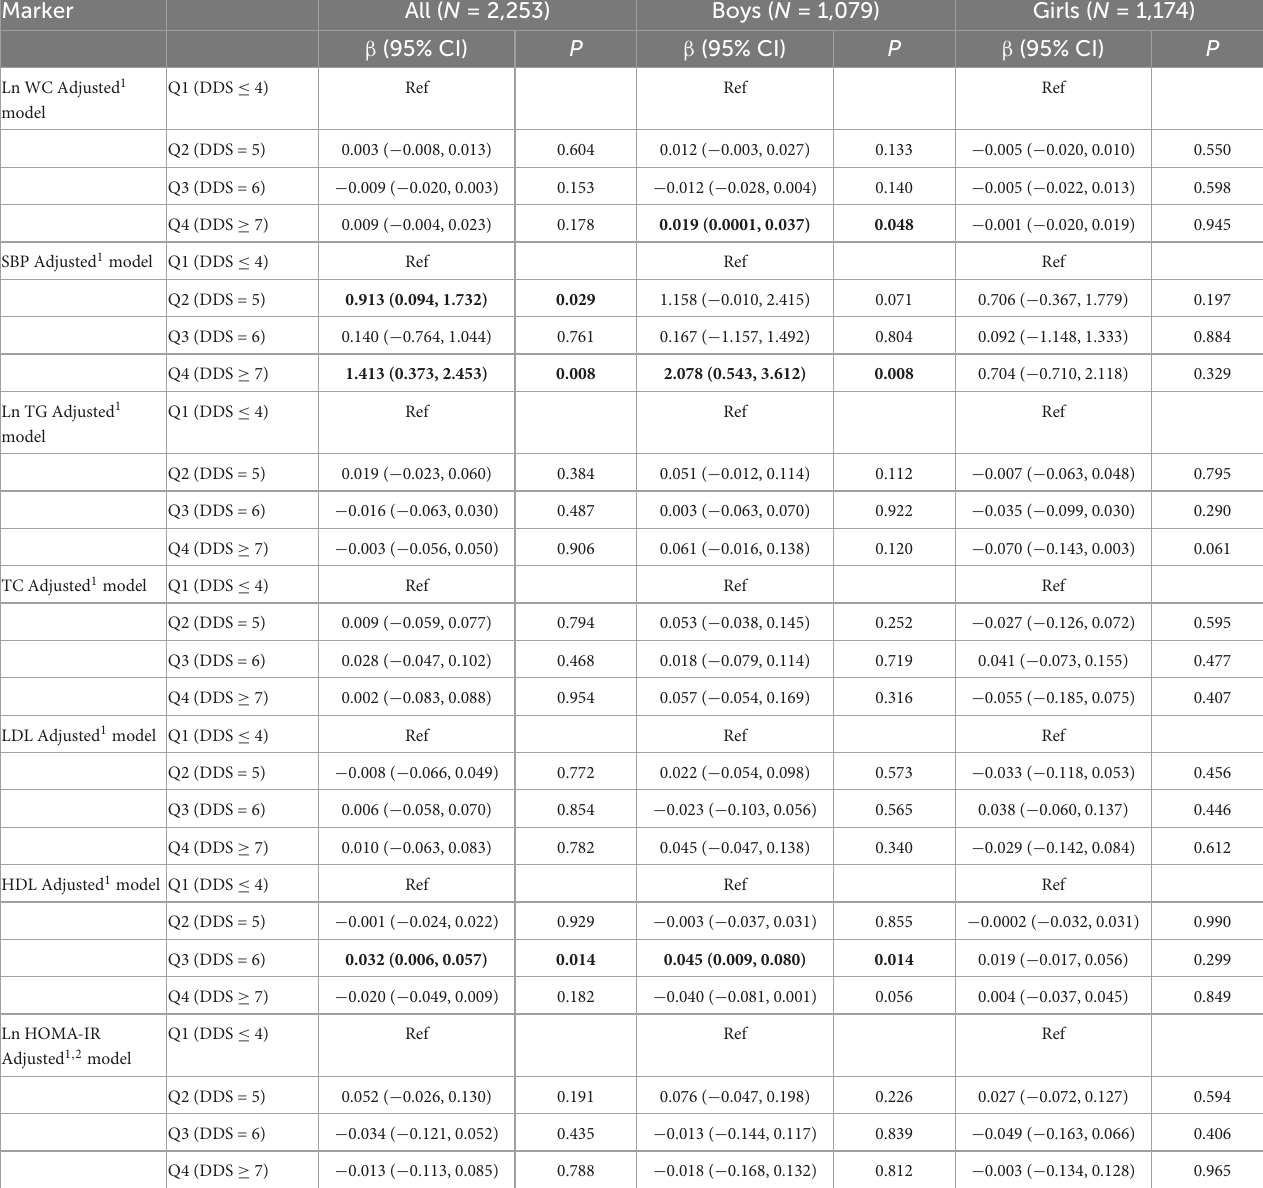
TABLE 5 Overall and gender-stratified associations of dietary diversity score (DDS) quartiles with anthropometric and blood markers of cardiometabolic risk among the Maternal and Infant Nutrition Intervention in Matlab (MINIMat) adolescents. Marker All ( N = 2,253) Boys ( N =